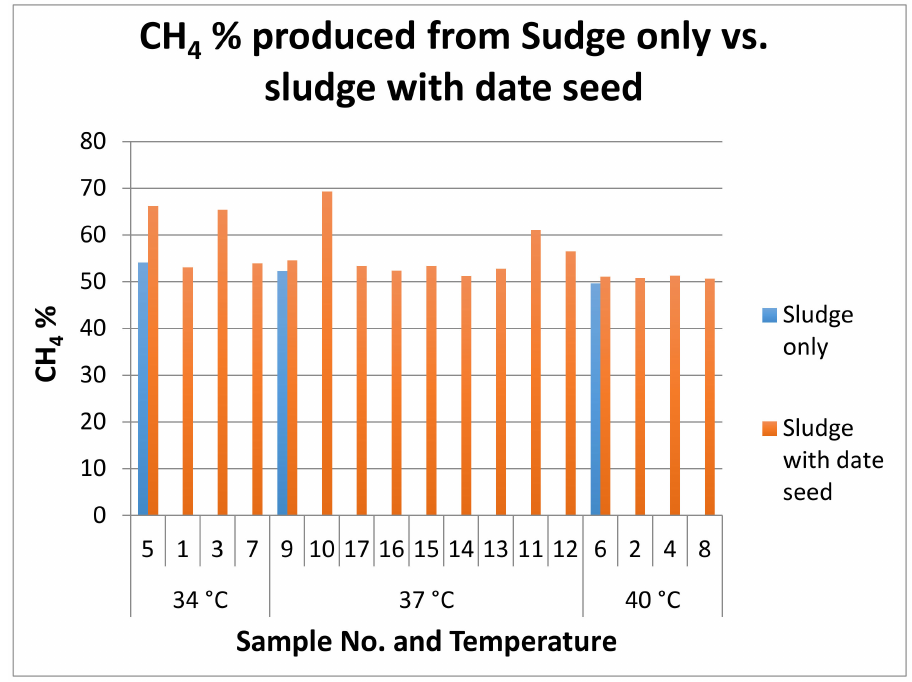
Figure 20. Different CH 4 % after adding date seed.